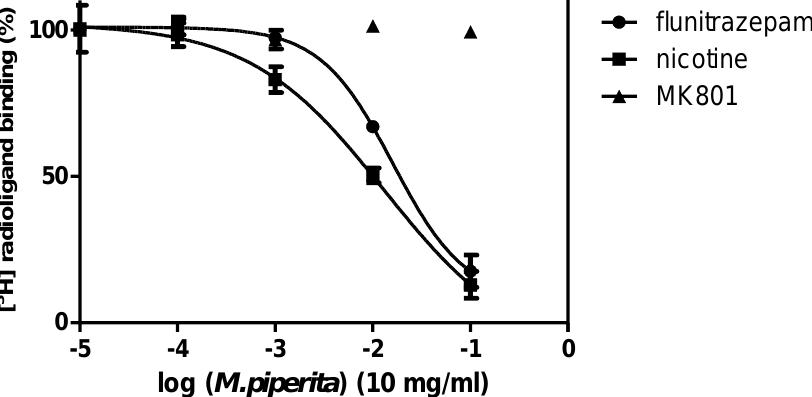
Figure 1. Dose-response radioligand binding properties of M. piperita essential oil (sample 4) in adult rat forebrain membranes at concentrations between, 0.000 and 1 mg/mL using [ 3 H] flunitrazepam, [ 3 H] MK-801 and [ 3 H] nicotine.